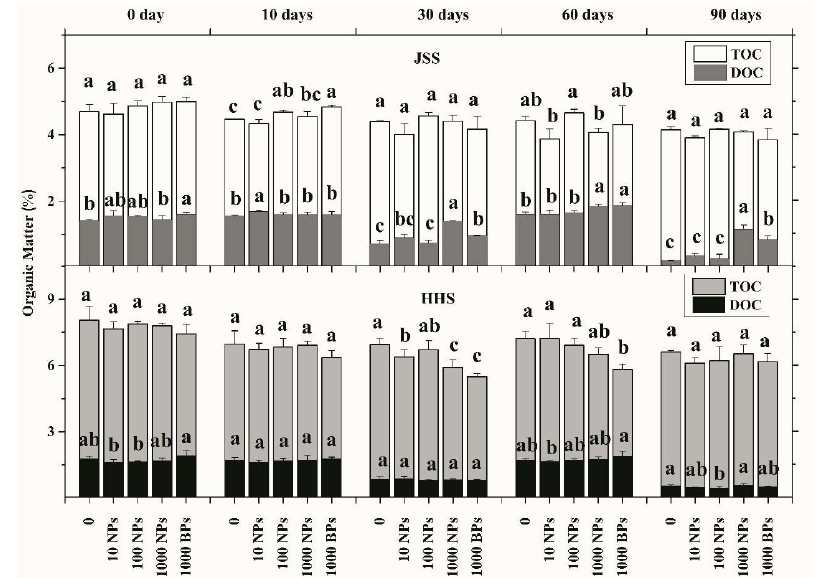
Figure 5. The total organic matter (TOC) and dissolved organic matter (DOC) of two tested soils during flooding–drying period. White: Jinshan Soil (JSS) TOC; Light Gray: Heihe Soil (HHS) TOC; Dark Gray: Jinshan Soil (JSS) DOC; Black: Heihe Soil (HHS) DOC. Error bars indicate the standard deviation of the mean ( n = 3). Lowercase letters indicate the significance between the different dose exposure treatments over the same period ( p < 0.05).